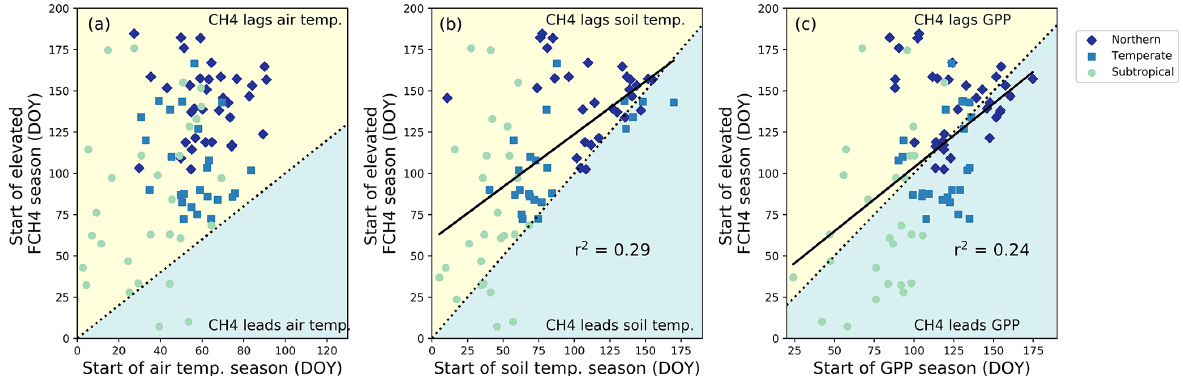
Figure 11. Relationship between the onset of the methane (CH 4 ) emission season to (a) the beginning of the air warming by day of year (DOY), (b) soil warming at the shallowest probe depth per site by DOY, and (c) gross primary productivity (GPP) increase for the subset of sites with soil temperature data by DOY. Each point represents a site year of data. Dashed lines represent a 1 : 1 relationship, and solid lines are significant ( p < 0.05) regression fits. On average, the CH 4 emission season lags behind the soil temperature increase by 31 ± 40d and is more synchronous with GPP.